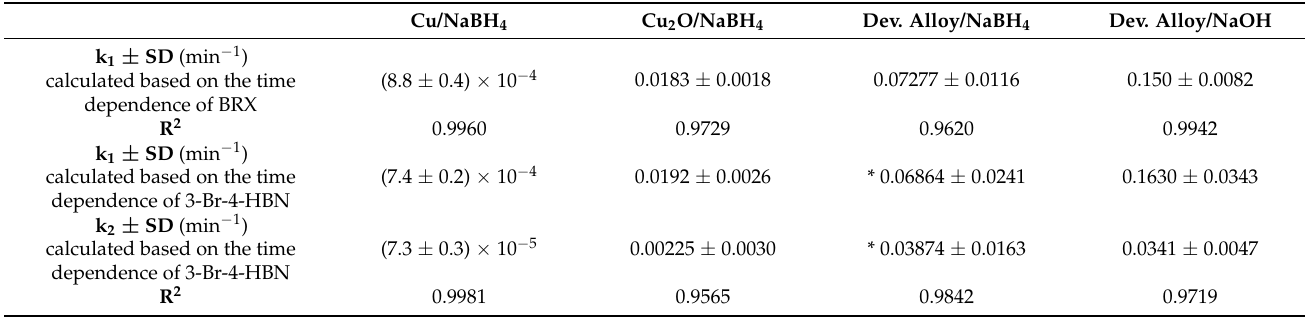
Figure 12. SEM images of the starting commercial Cu 2 O after the treatment of 5 mM BRX solution in 20 mM aqueous NaOH without added NaBH 4 ( left ) and separated insoluble part (mixture of Cu and Cu 2 O nanoparticles) after the HDB of BRX (5 mM BRX solution in 20 mM aqueous NaOH) using Cu 2 O/NaBH 4 ( right ). Table 2. Calculated kinetic constants (k 1 and k 2 ) for the HDB of BRX using different Cu-based HDB agents (k 1 represents the first order rate constant of the first reaction step and k 2 represents the rate constant of the second reaction step (see Scheme 1), SD is standard deviation and R 2 is coefficient of